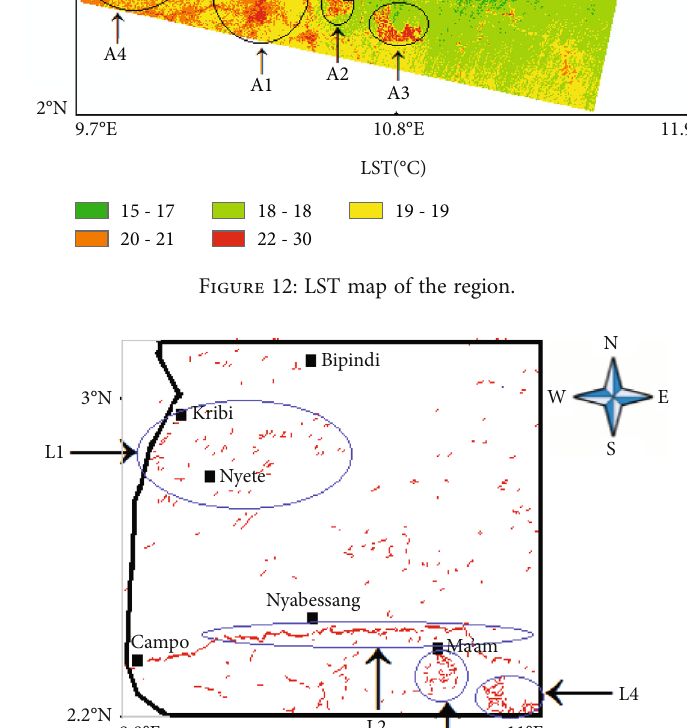
Figure 13: Lineament map of the study